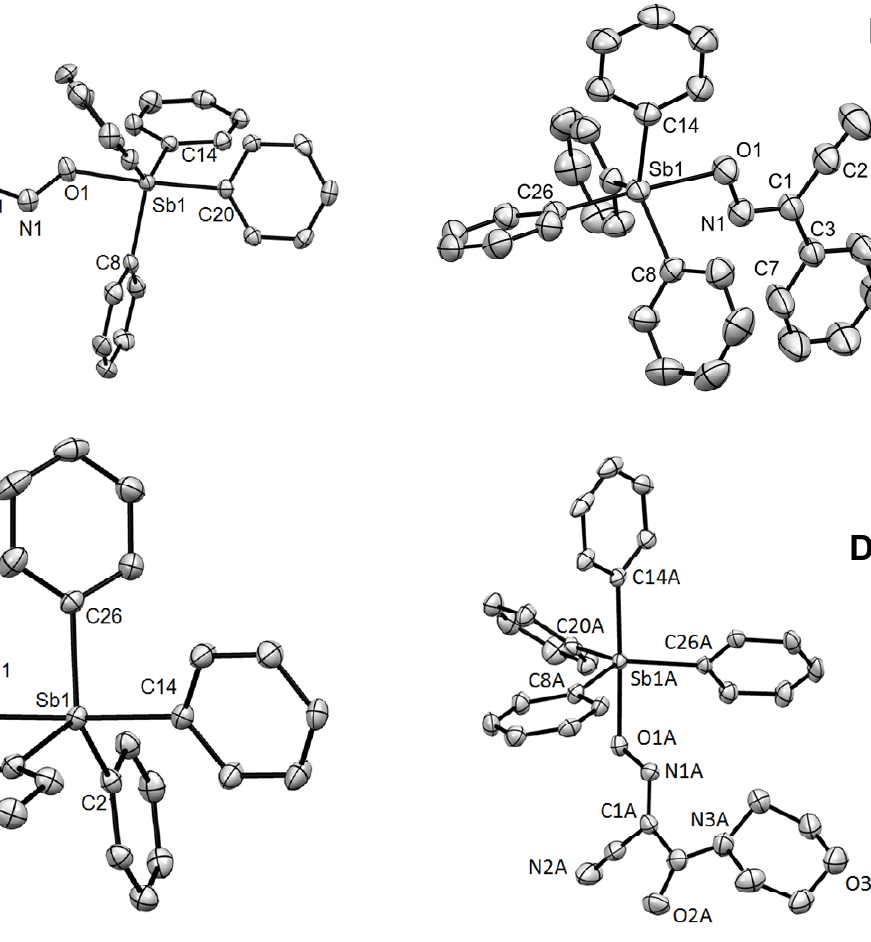
Figure 3. The ASU in the structures of SbPh 4 (2PCO) ( A ), SbPh 4 (3PCO) ( B ), SbPh 4 (4PCO) ( C ), and SbPh 4 (MCO) ( D ); only one of two independent molecules is displayed. SbPh 4 (ECO) ( E ) (only one of two independent molecules present) and SbPh 4 (ACO) ( F ), showing numbering of principal atoms only. Details of the geometry of crystal structures are presented in SI section. H-atoms are omitted for clarity.